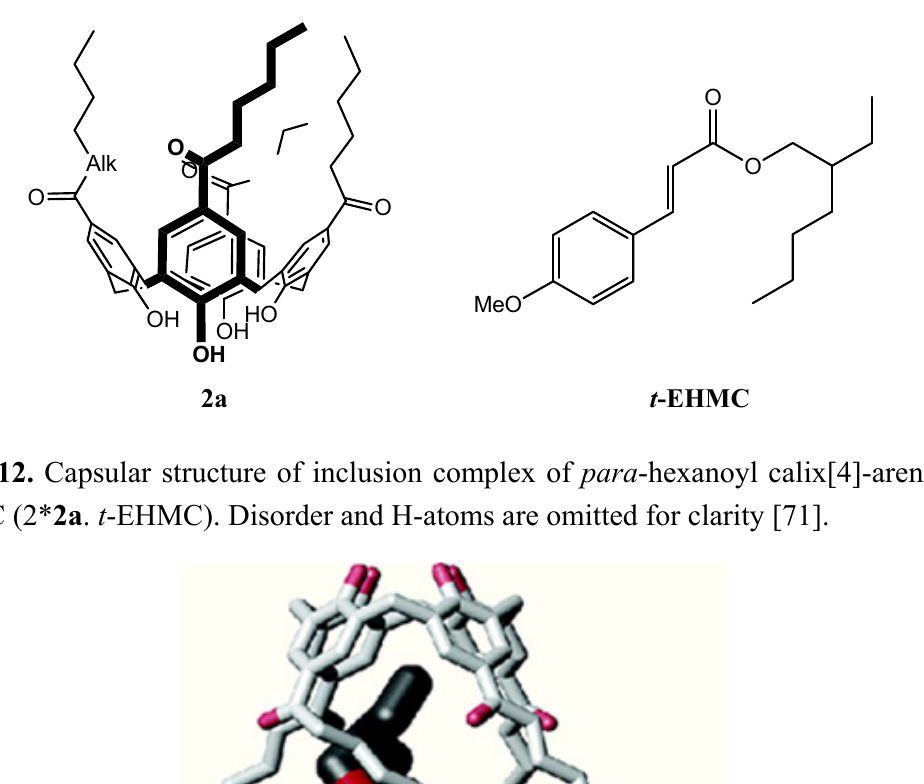
Figure 11. Structures of para -Hexanoyl Calix[4]arene ( 2a ) and t -EHMC.